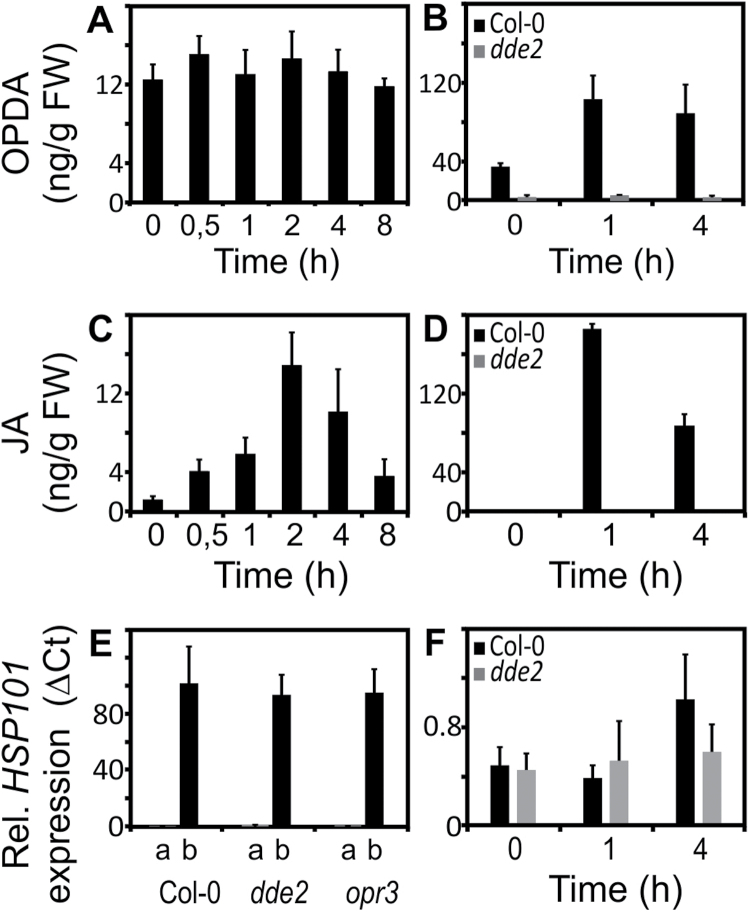
Heat- and wound-induced jasmonate accumulation and HSP101 expression. Time-course of jasmonate accumulation in seedlings shifted to 37 °C (A, C) and wounded wild-type and dde2 leaves from 6-week-old plants (B, D). Relative HSP101 expression (as determined by qPCR and normalized to AtSAND expression) in wild-type and mutant seedlings after 1 h at the temperatures indicated (E) or after wounding (F). Data represent means ±SD, n=3.